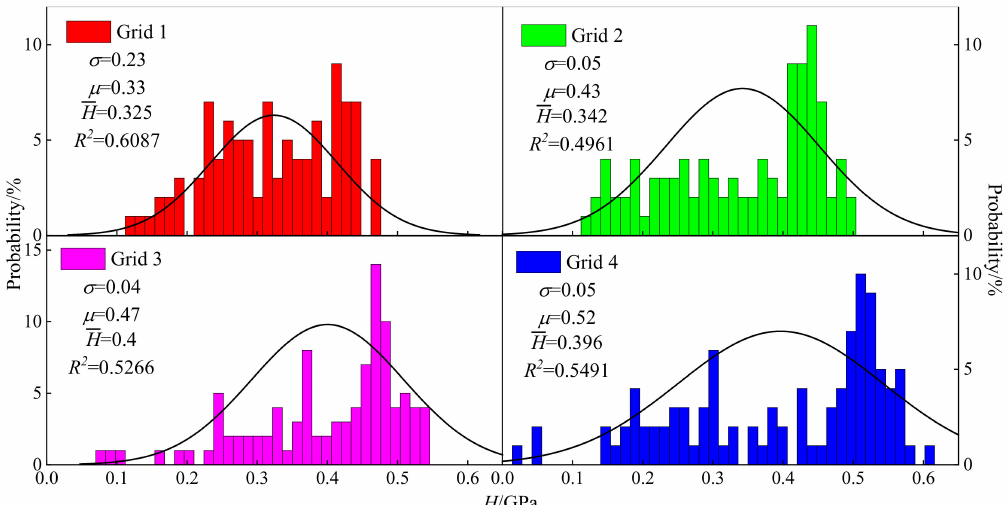
Figure 8. Frequency distribution histogram of H . The closer the value of R 2 is to 1, the better the fit of the regression line to the observed values; on the contrary, the smaller the value of R 2 , the worse the fit of the regression line to the observed values.